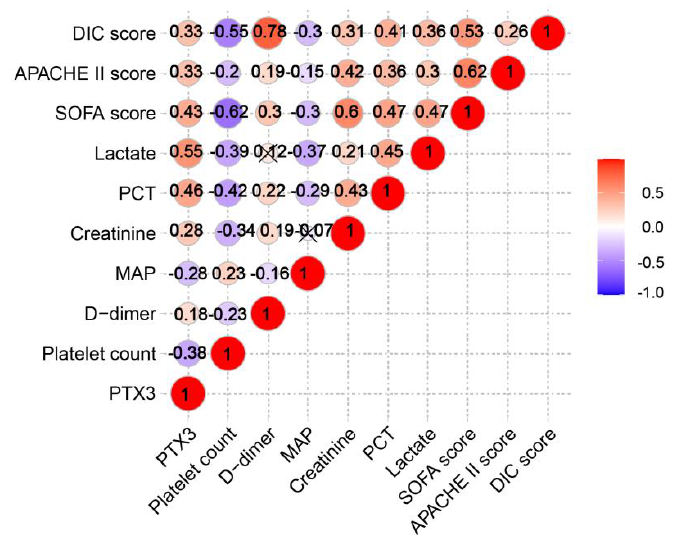
Figure 3. Correlations of PTX3 with traditional severity parameters in ICU patients with sepsis and septic shock. The significance of correlations is shown in the upper correlation heatmap.